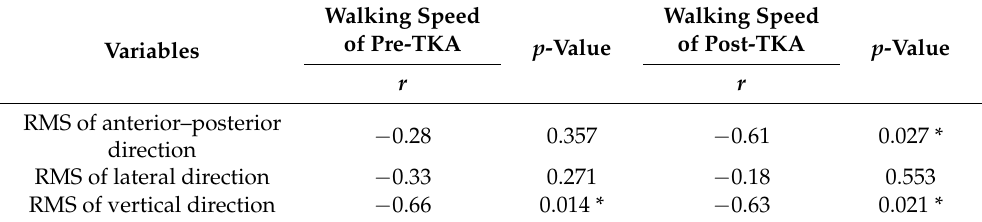
Table 2. Pearson correlation coefficients between the RMS and walking speed.